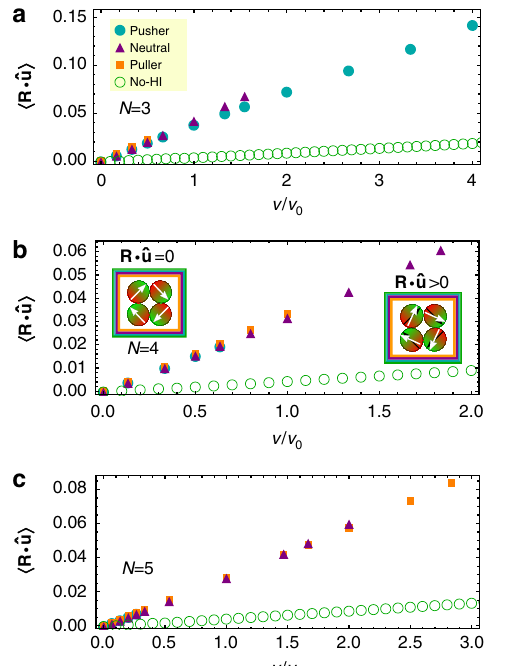
Figure 6 | Alignment of dipoles within a ring-like structure. Alignment of the swimmer within a ring-like chain measured by the product of the swimmers orientation ^ u and R ¼ r i (cid:2) r cv for ( a ) N ¼ 3, ( b ) N ¼ 4 and ( c ) N ¼ 5 swimmers.